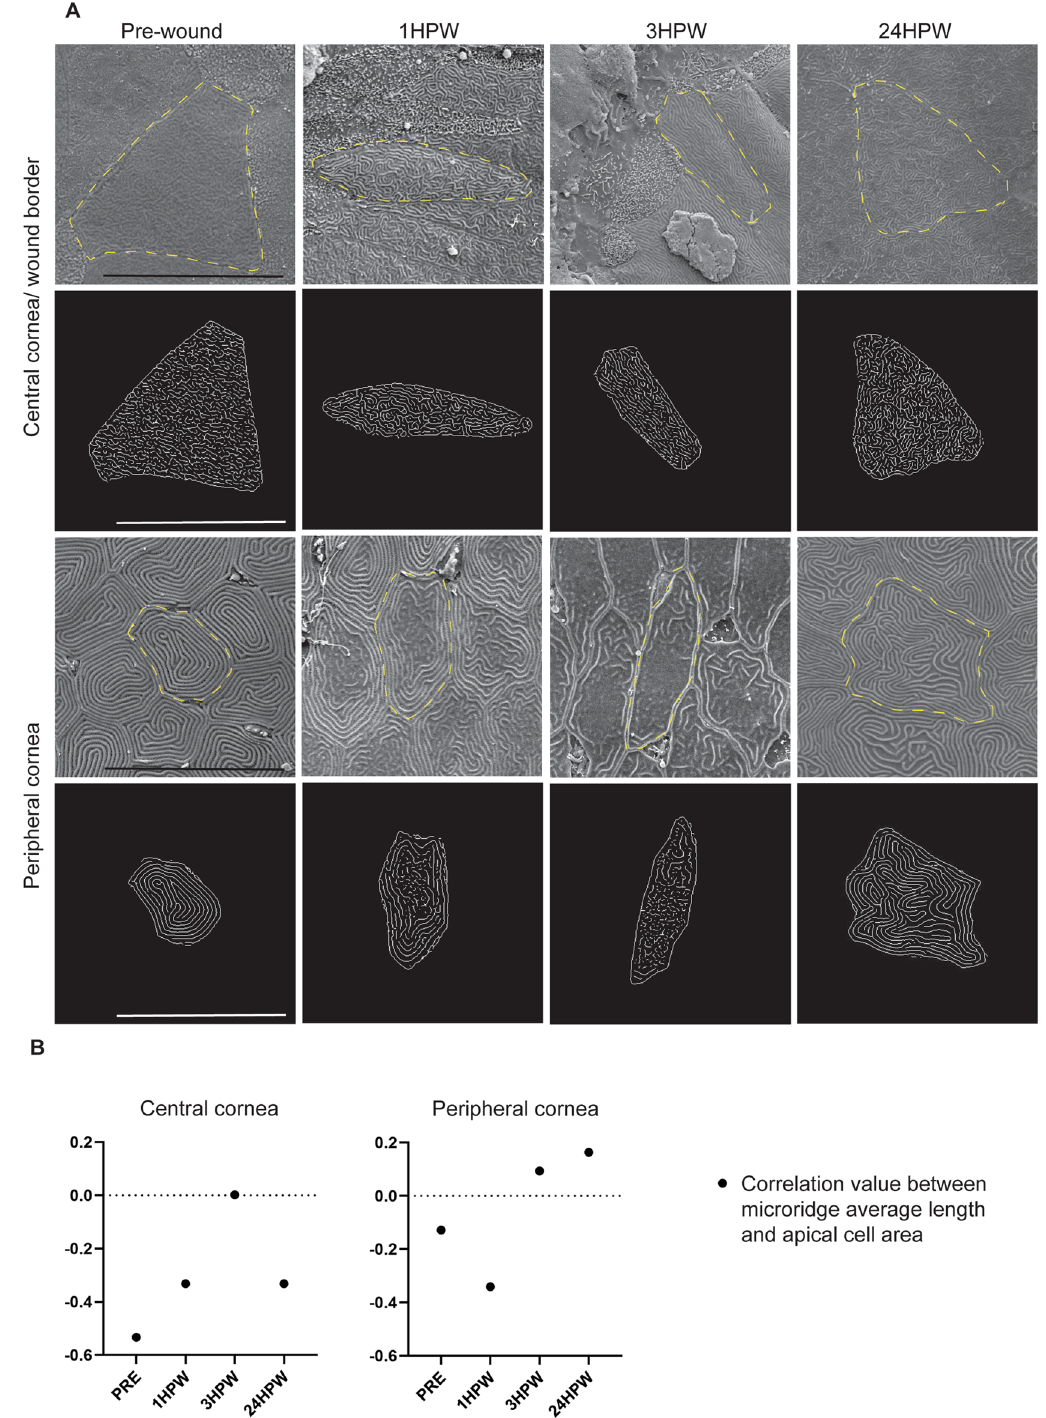
Figure 7. Microridge modification during corneal wound closing. ( A ) Representative SEM images and corresponding digitally generated microridge patterns before and 1, 3 and 24HPW on central and peripheral cornea. ( B ) Spearman correlation between average microridge length, and apical cell area, on central and peripheral cornea demonstrates the long-lasting modification of microridges during corneal wound healing (n-numbers after removal of outliers in pre-, 1, 3, and 24HPW, respectively: CC, microridge average length: 51, 47, 30, and 43, PC, microridge average length: 162, 171, 209, and 203). Data represent mean + 95% confidence interval, P ** < 0.01, P *** < 0.001, P **** < 0.0001. B: Kruskal–Wallis test followed by Dunn’s test for multiple comparisons. Cells from 3 eyes were pooled for all analyses. CC: central cornea, PC: peripheral cornea. Scale bars: 20 µm. HPW: hours